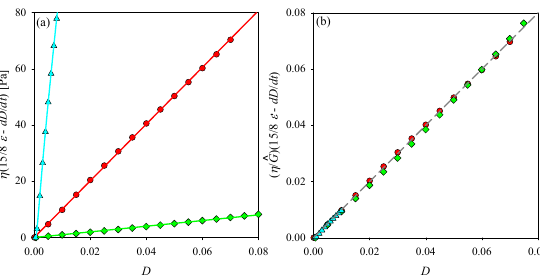
Figure 2. (a) Green diamonds, red circles, cyan triangles: Taylor plot of η (15 / 8˙ ε − dD / dt ) versus D for three di ff erent G -values. Green, red, cyan lines: linear fits of the three series of symbols (the slopes are equal to 100.71, 1009.5, 9998 Pa, respectively). (b) Taylor plot of ( η/ ˆ G )(15 / 8˙ ε − dD / dt ) versus D , with ˆ G the estimated value of the particle shear modulus, for the same data sets as in panel